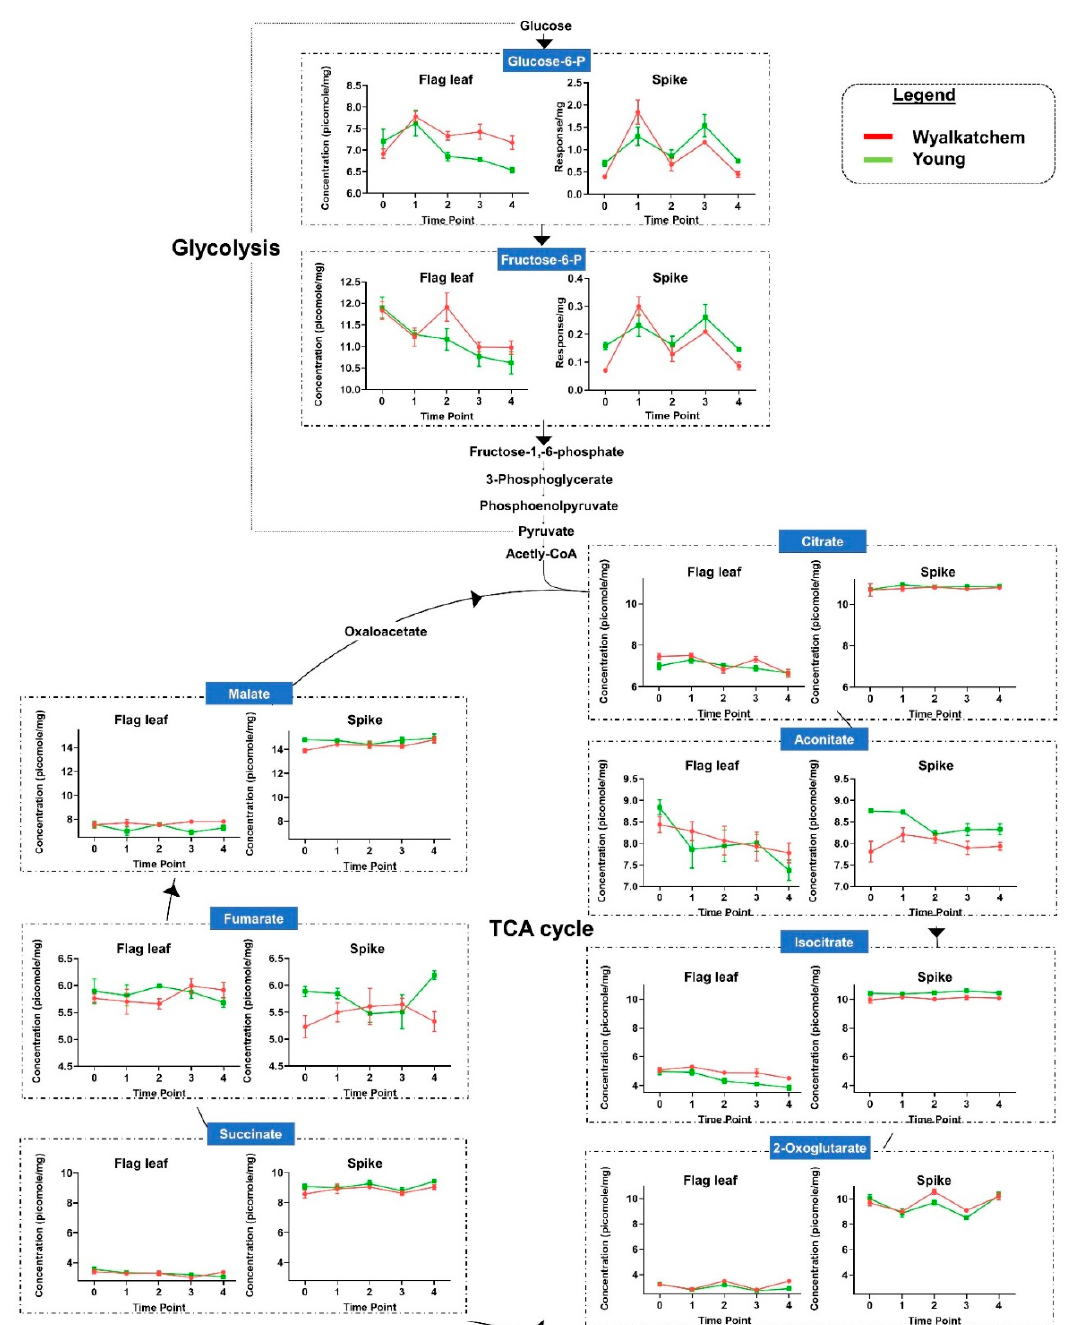
Figure 6. Comparison of primary metabolites involved in glycolysis and the tricarboxylic acid cycle (TCA) cycle, the two main energy-providing pathways of the cell. The graphs show differences in relevant primary metabolite concentrations (picomole/mg of fresh weight, Log 2 -transformed) between flag leaf and spike metabolite data. For glucose-6-phosphate and fructose-6-phosphate, the spike data compare the response normalized per mg of fresh weight. The graphs reveal differences in accumulation levels of these metabolites in cold-tolerant Young and cold-sensitive Wyalkatchem spikes. n = 4 ± SEM for flag leaf, n = 3 ± SEM for spikes.